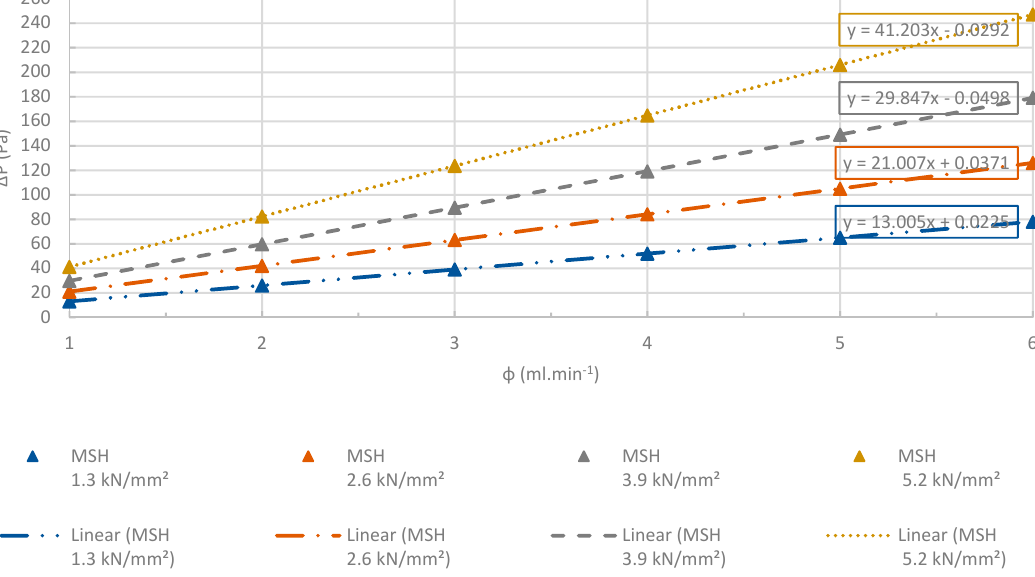
Figure 25. Changes at differential pressures with increasing flow rates. The SBH/G+C (1:1) pellets manufactured at several different compression pressures were dehydrated completely before the test. R 2 > 0.99. The accuracy of the pressure measurements was less than 0.1%.